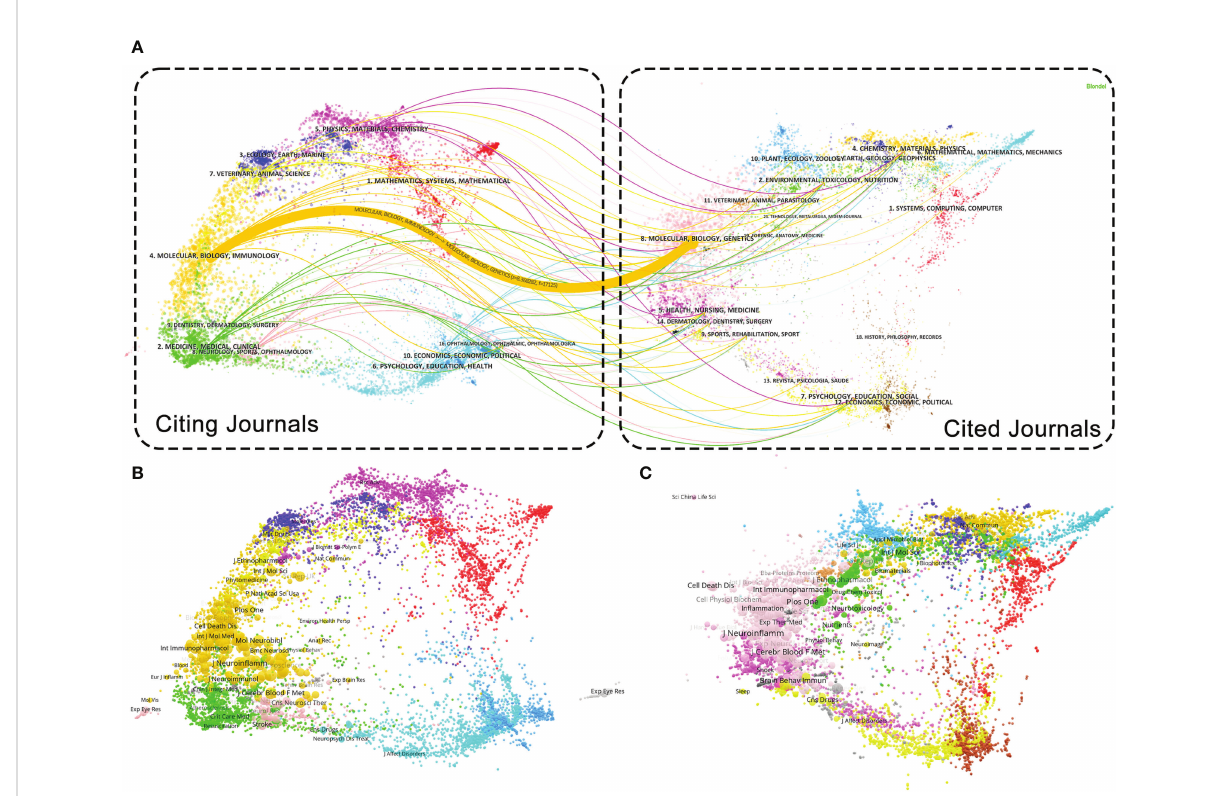
FIGURE 5 Journal overlay map. (A) Dual map overlay of journals. The citing journals collection is on the left, the cited journals collection is on the right, and the colored paths indicate the citation relationships; (B) Citing journals overlay; (C) Cited journals